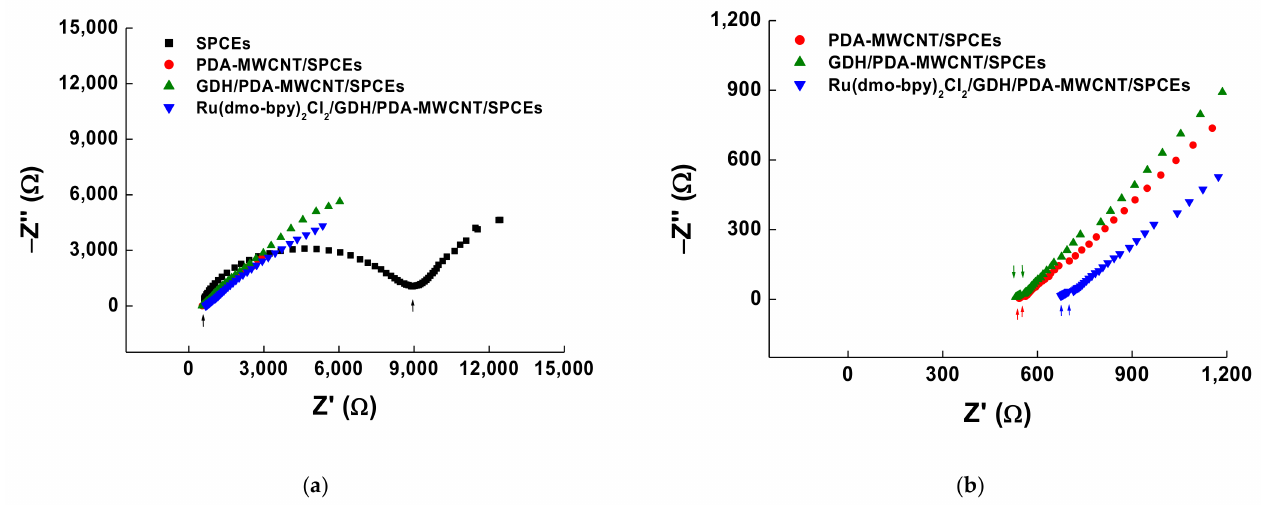
Figure 4. Nyquist plot of ( a ) normal and ( b ) zoom for bare SPCEs (black square), PDA-MWCNT/SPCEs (red circle), GDH/PDA-MWCNT/SPCEs (green triangle), and Ru(dmo-bpy) 2 Cl 2 /GDH/PDA-MWCNT/SPCEs (blue reverse